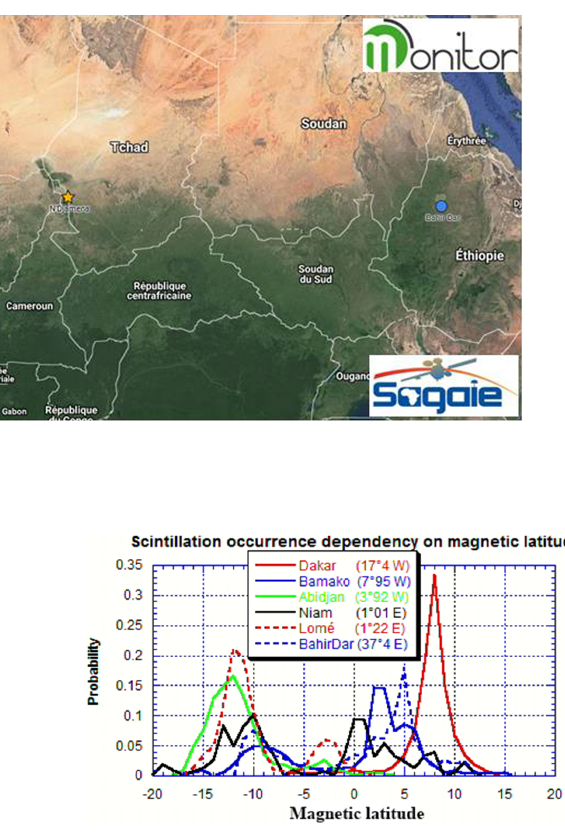
Figure 2. Scintillation probability of occurrence at low latitudes in Africa during the years 2015 and